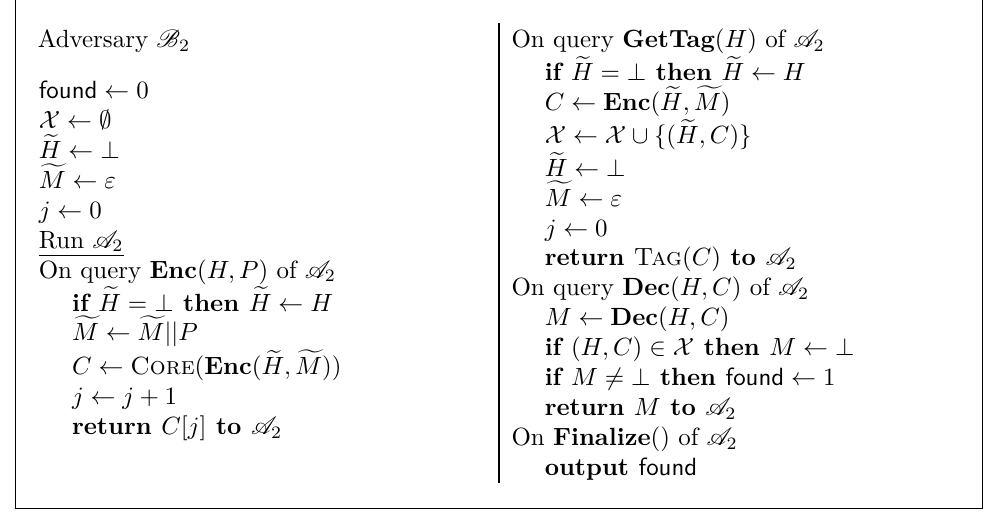
Figure 7: Adversary B 2 for the proof of Theorem